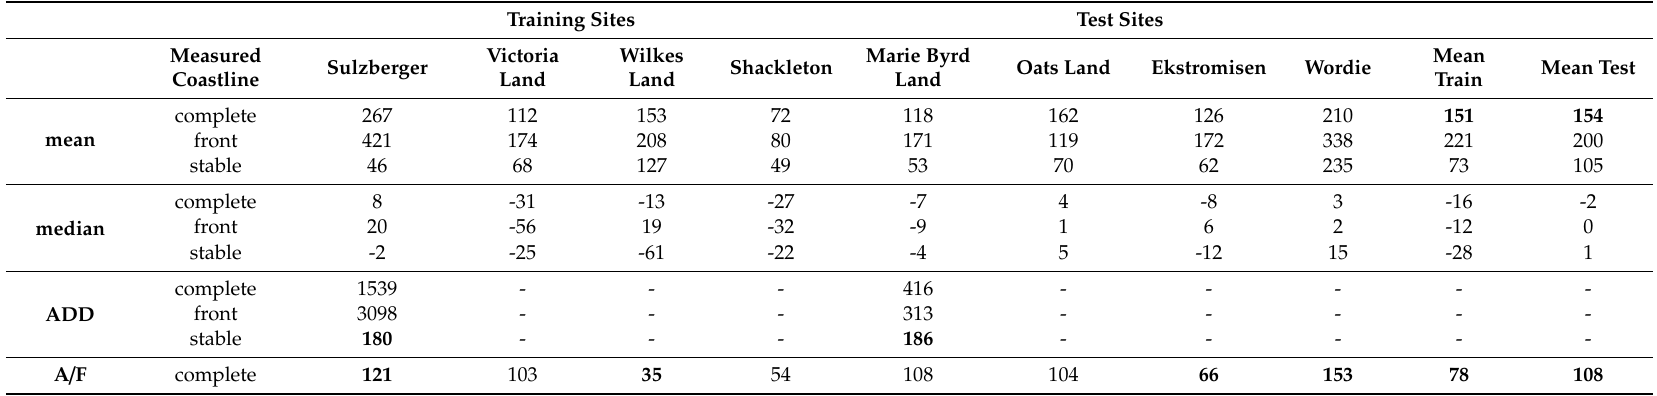
Table 2. Distance measured errors (in meters) along transects for frontal and stable coastline sections as well as the entire study region. An estimate for the di ff erence between two manually delineated coastlines is given with the ADD (Antarctic Digital Database) coastline (mean error). A / F is the averaged width of the enclosed area between the automated and manual delineated coastline for each study